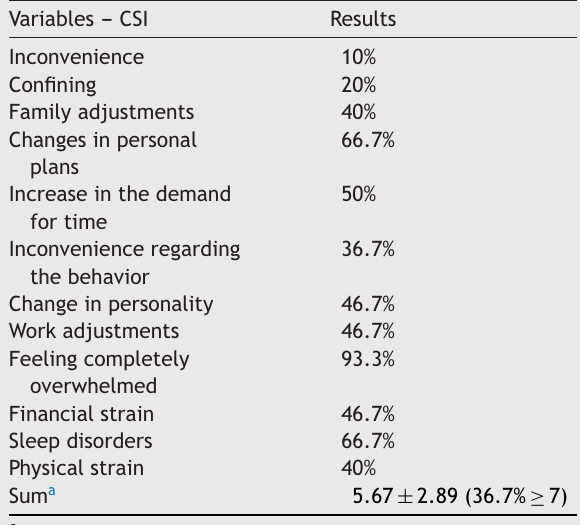
Caregiver Strain Index (CSI) questionnaire applied to